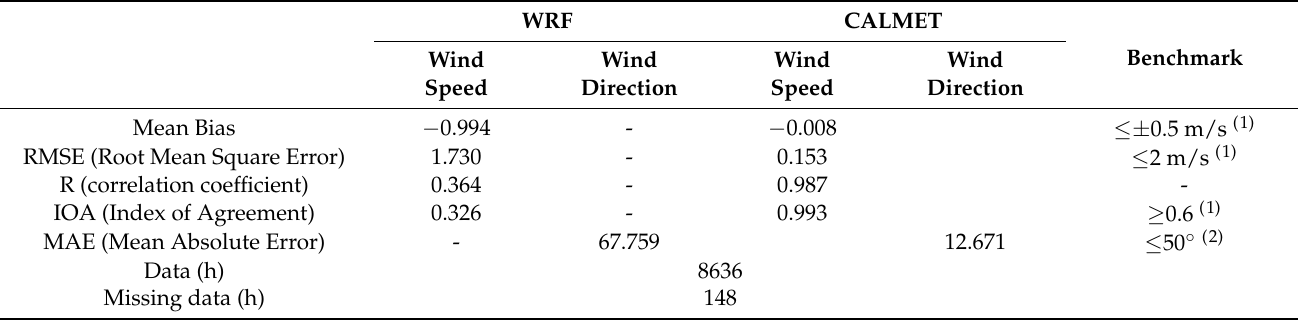
Table 3. Statistical metrics for WRF and CALMET